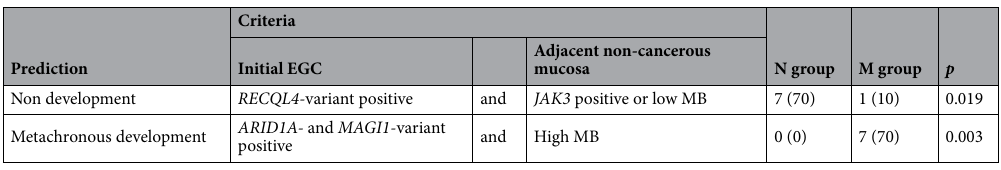
Table 2. Predictive criteria for MGC development or non-development. Values are expressed as n